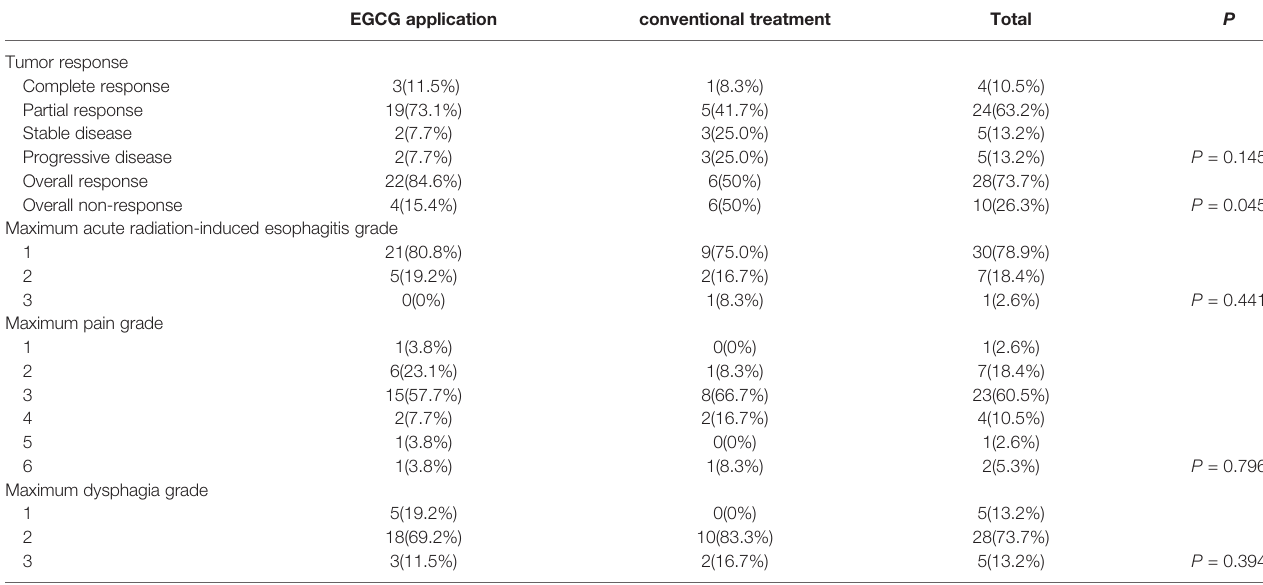
TABLE 2 | Distribution of maximum grade of esophagitis-related parameters and tumor response.